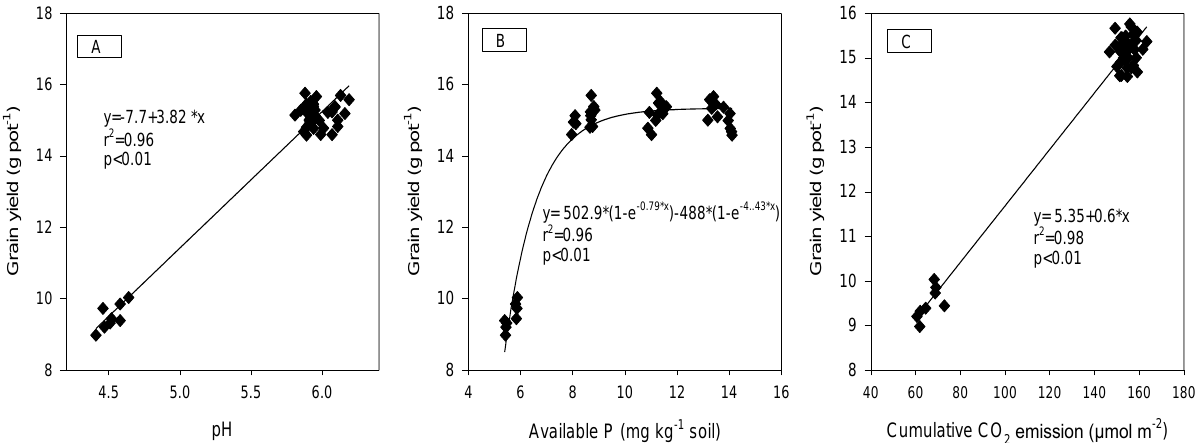
Figure 6. Relationship between soil pH, soil available P, and cumulative CO 2 emission against grain yield ( A – C ), respec- tively.